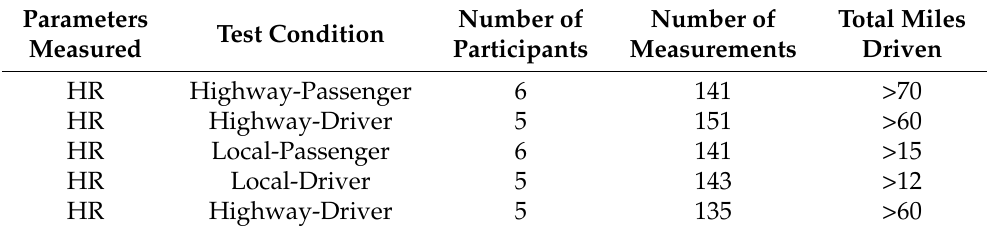
Table 2. Testing condition for each of the scenario tested. Parameters